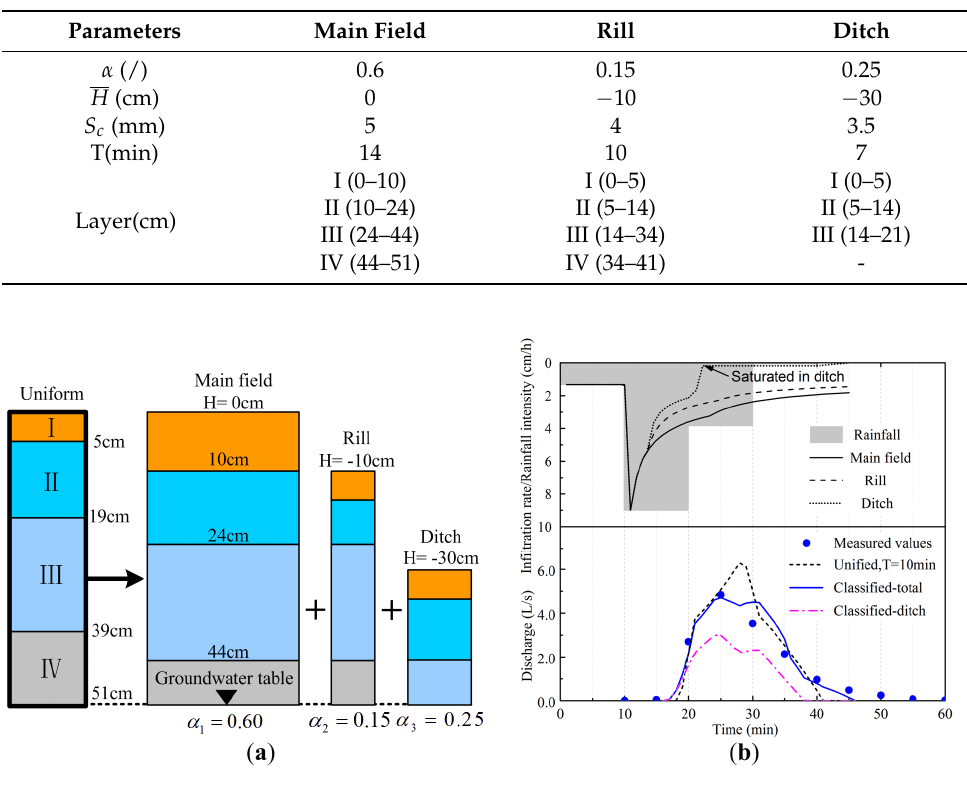
Figure 8. The 20160808 runoff case considering the effect of microtopography: ( a ) classified topography setting; ( b ) observed and simulated results.